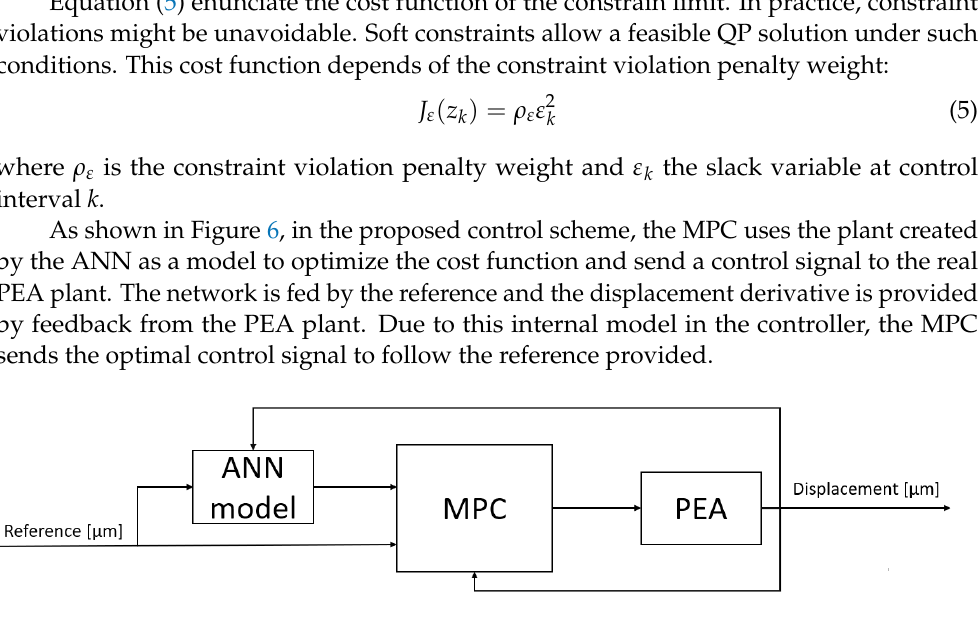
Figure 6. Model Predictive Control (MPC) control